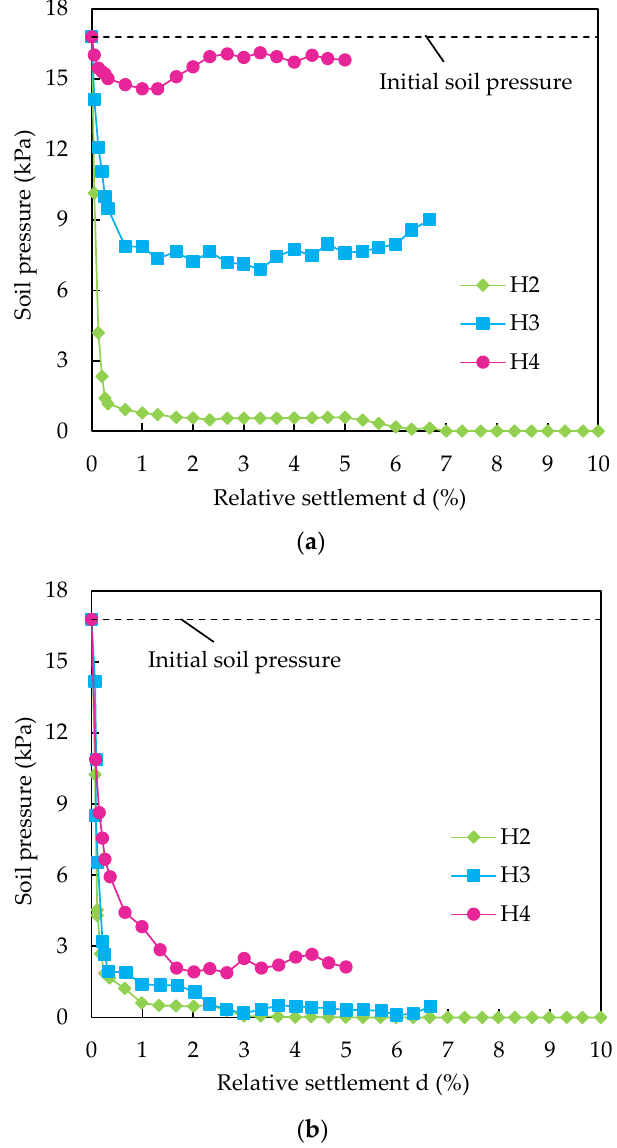
Figure 5. Change of soil pressure of the subsidence area: ( a ) soil pressure variation curve of the location of T1 with the relative settlement; ( b ) soil pressure variation curve of the location of T2 with the relative settlement.